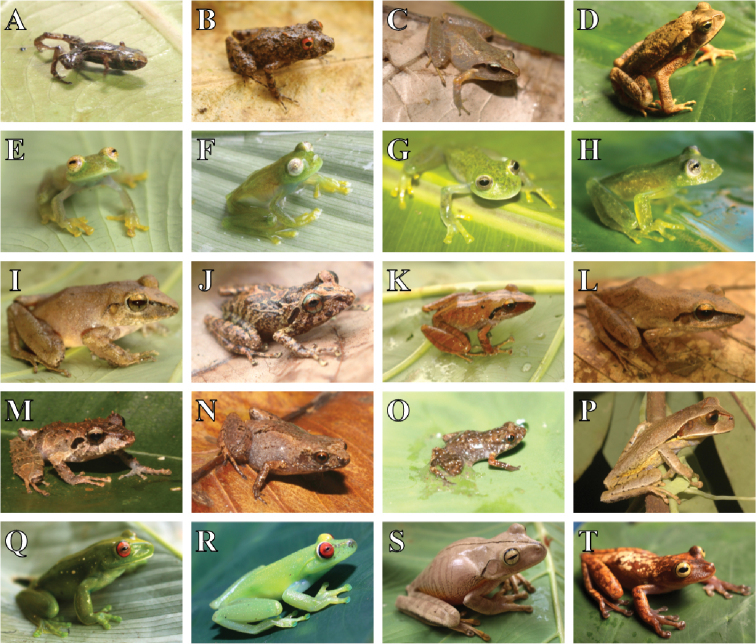
Amphibians recorded in the Parque Nacional da Serra das Lontras: ABrachycephalus
pulexBIschnocnema
verrucosaCIschnocnema
cf.
parvaDRhinella
cruciferEVitreorana
baliommaFV.
eurygnathaGVitreorana sp.nov. HV.
uranoscopaIHaddadus
binotatusJPristimantis sp. 1 KPristimantis sp. 2 LPristimantis
paulodutraiMPristimantis
vinhaiNAdelophryne sp. 8 OAdelophryne sp. 2 PGastrotheca
recavaQAplastodiscus
ibirapitangaRA.
weygoldtiSBoana
faberTBokermannohyla
lucianae.